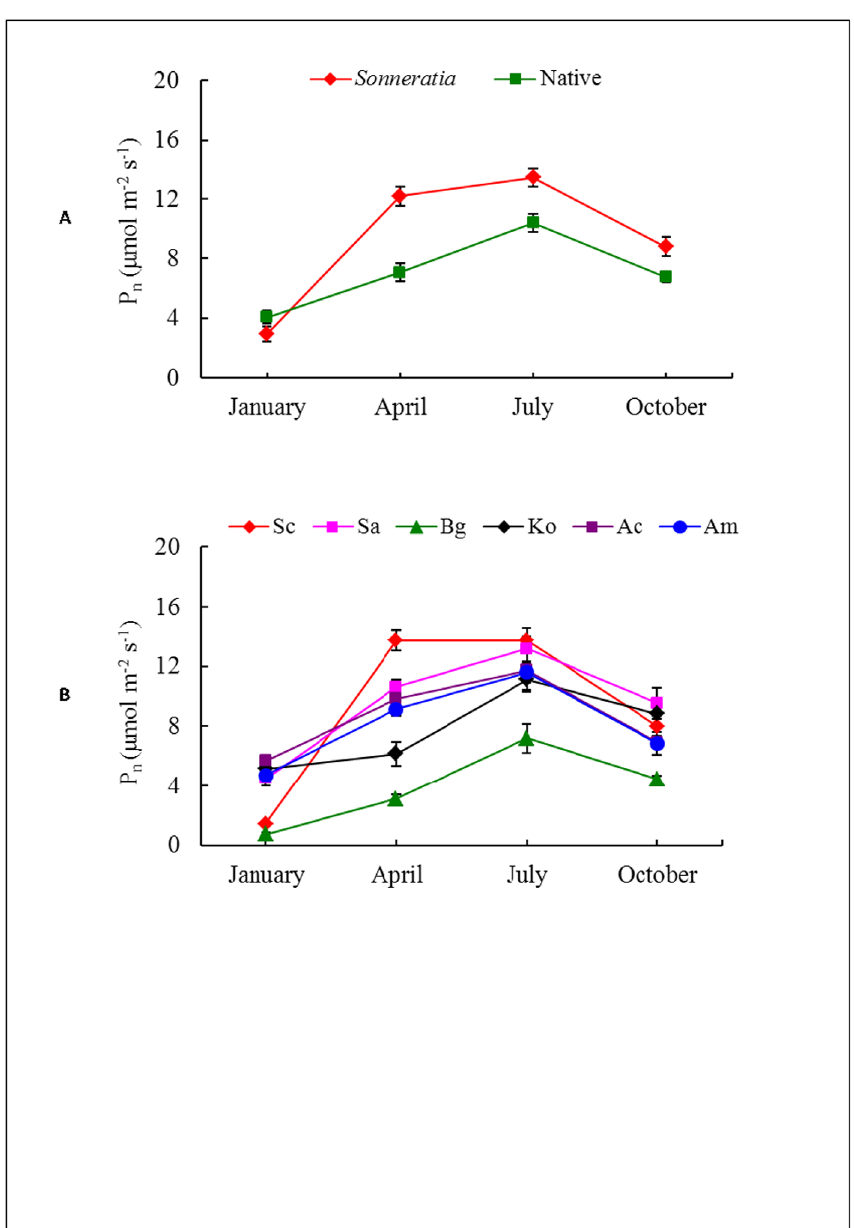
Fig 2. Seasonal dynamics of the net photosynthetic rate (P n ) of alien Sonneratia and native mangrove species. Fig 2 legend: Error bars represent ± 1 SE.